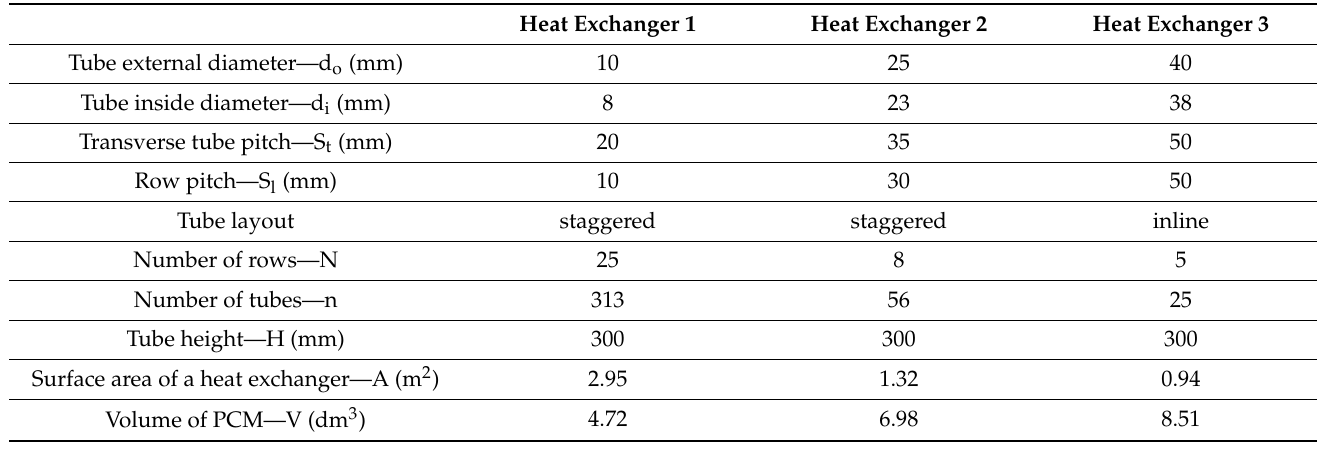
Table 2. Heat exchangers parameters.